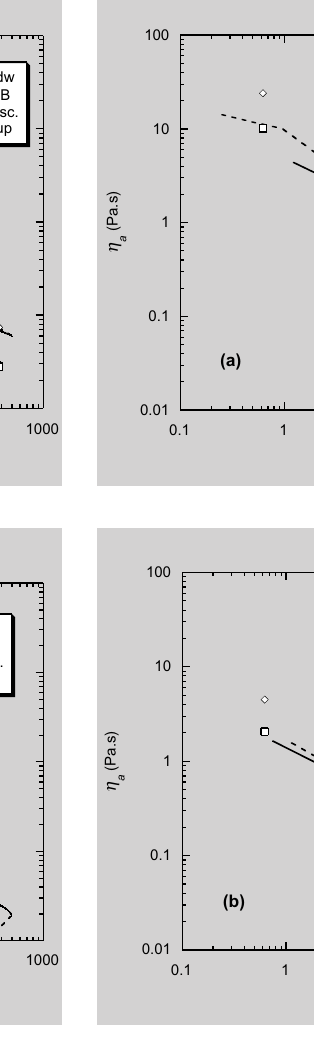
Figure 2: Apparent viscosity up (ap.visc.up) and down (ap.visc.dw) curves, apparent viscosity predicted using Eq. 2 (ap.visc-b), and complex viscosity (compl.visc.) for cross-linked waxy maize (CWM) at a) (left above) 5 % and b) (left below) 3.5% w/w. Figure 3. Apparent viscosity up (ap.visc.up) and down (ap.visc.dw) curves, apparent viscosity predicted using Eq. 2 (ap.visc-b), and complex viscosity (compl.visc.) for tapioca at a) (right above) 4 % and b) (right below) 2.8 %